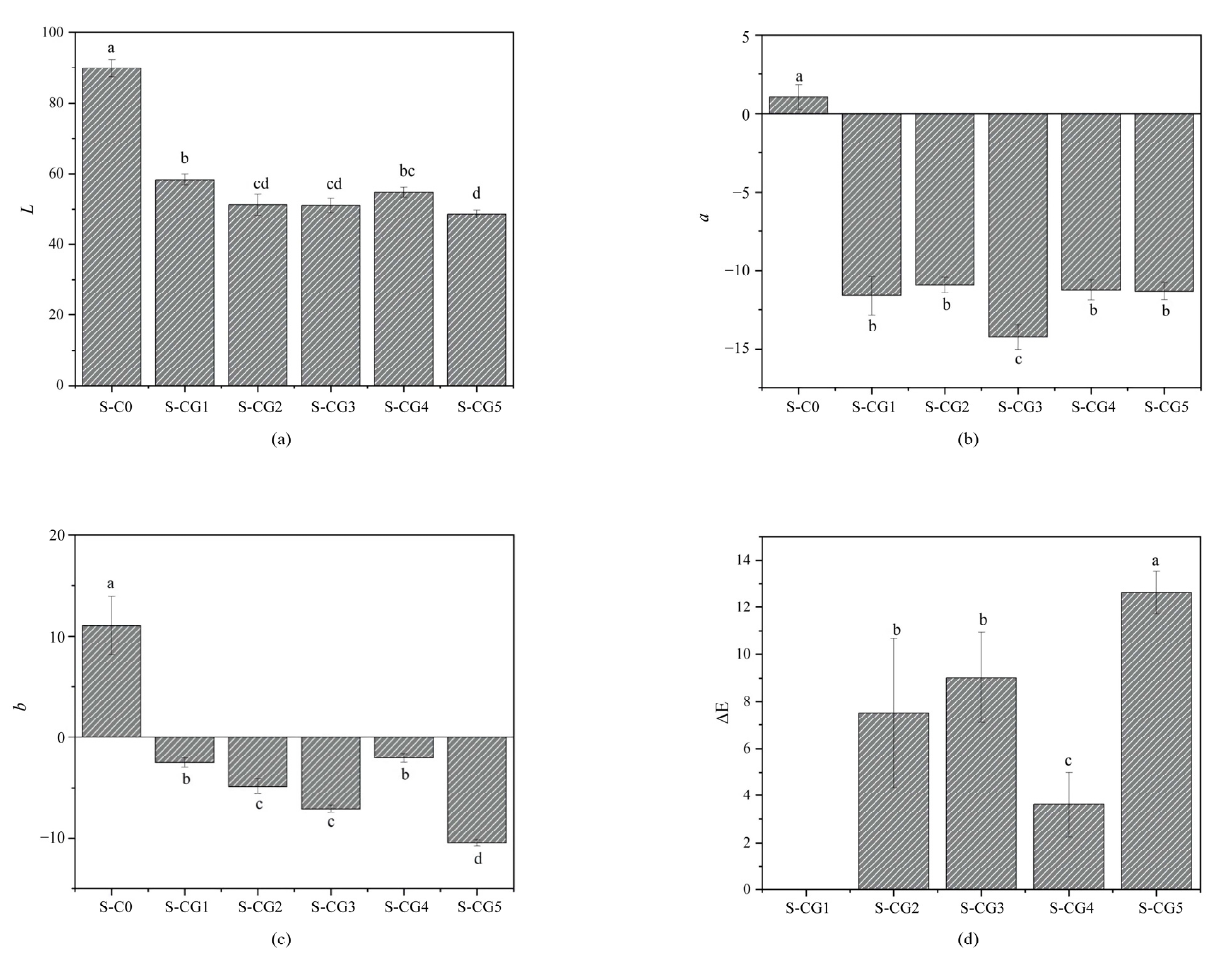
Figure 4. The chroma values of composite films. ( a ) L : lightness/brightness, ( b ) a : redness/greenness, ( c ) b : yellowness/blueness, ( d ) ∆ E: the color difference. Results are expressed as average, and different letters (a–d) indicate significant differences ( p < 0.05).